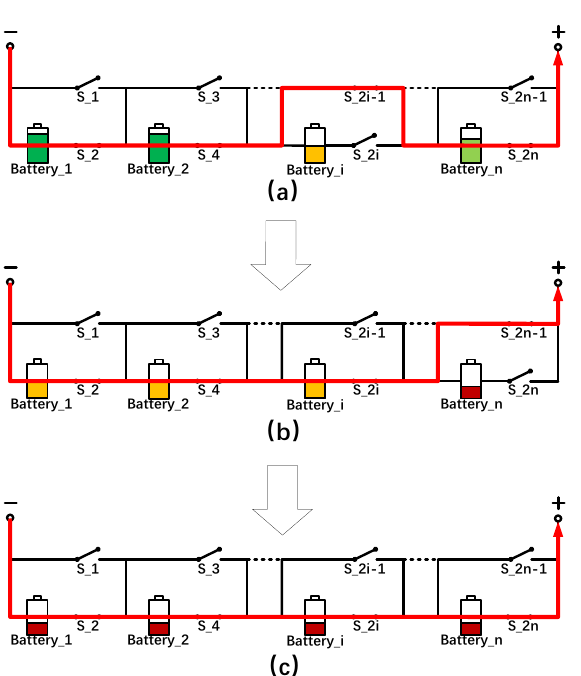
Figure 3. Equalization process: ( a ) At the beginning of the equalization, battery i is isolated; ( b ) In the middle of the equalization, battery n is isolated; ( c ) End of equalization.